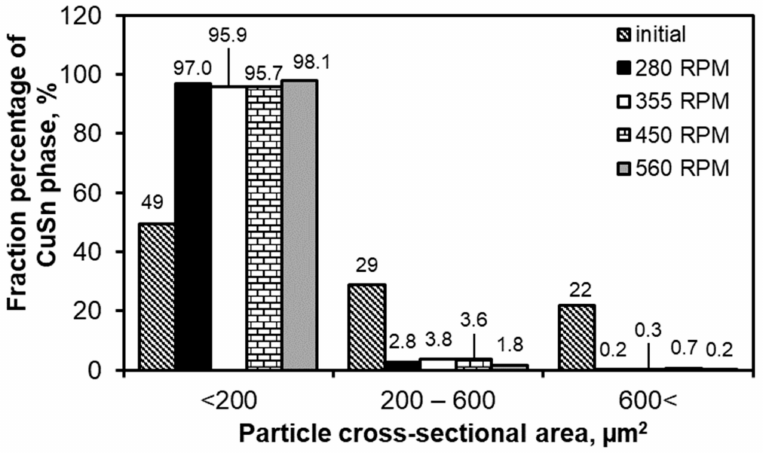
Figure 5. Results of statistical analysis of CuSn precipitates depending on FSP conditions; results are related to the alloy in initial state after casting.